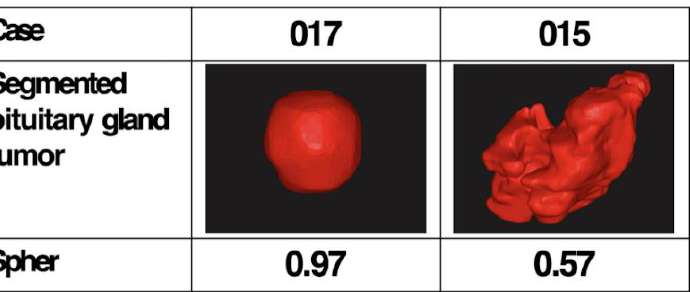
Figure 2. Examples of pituitary gland tumor with different sphericity (Spher) values: from high (left side) to low (right side) values.